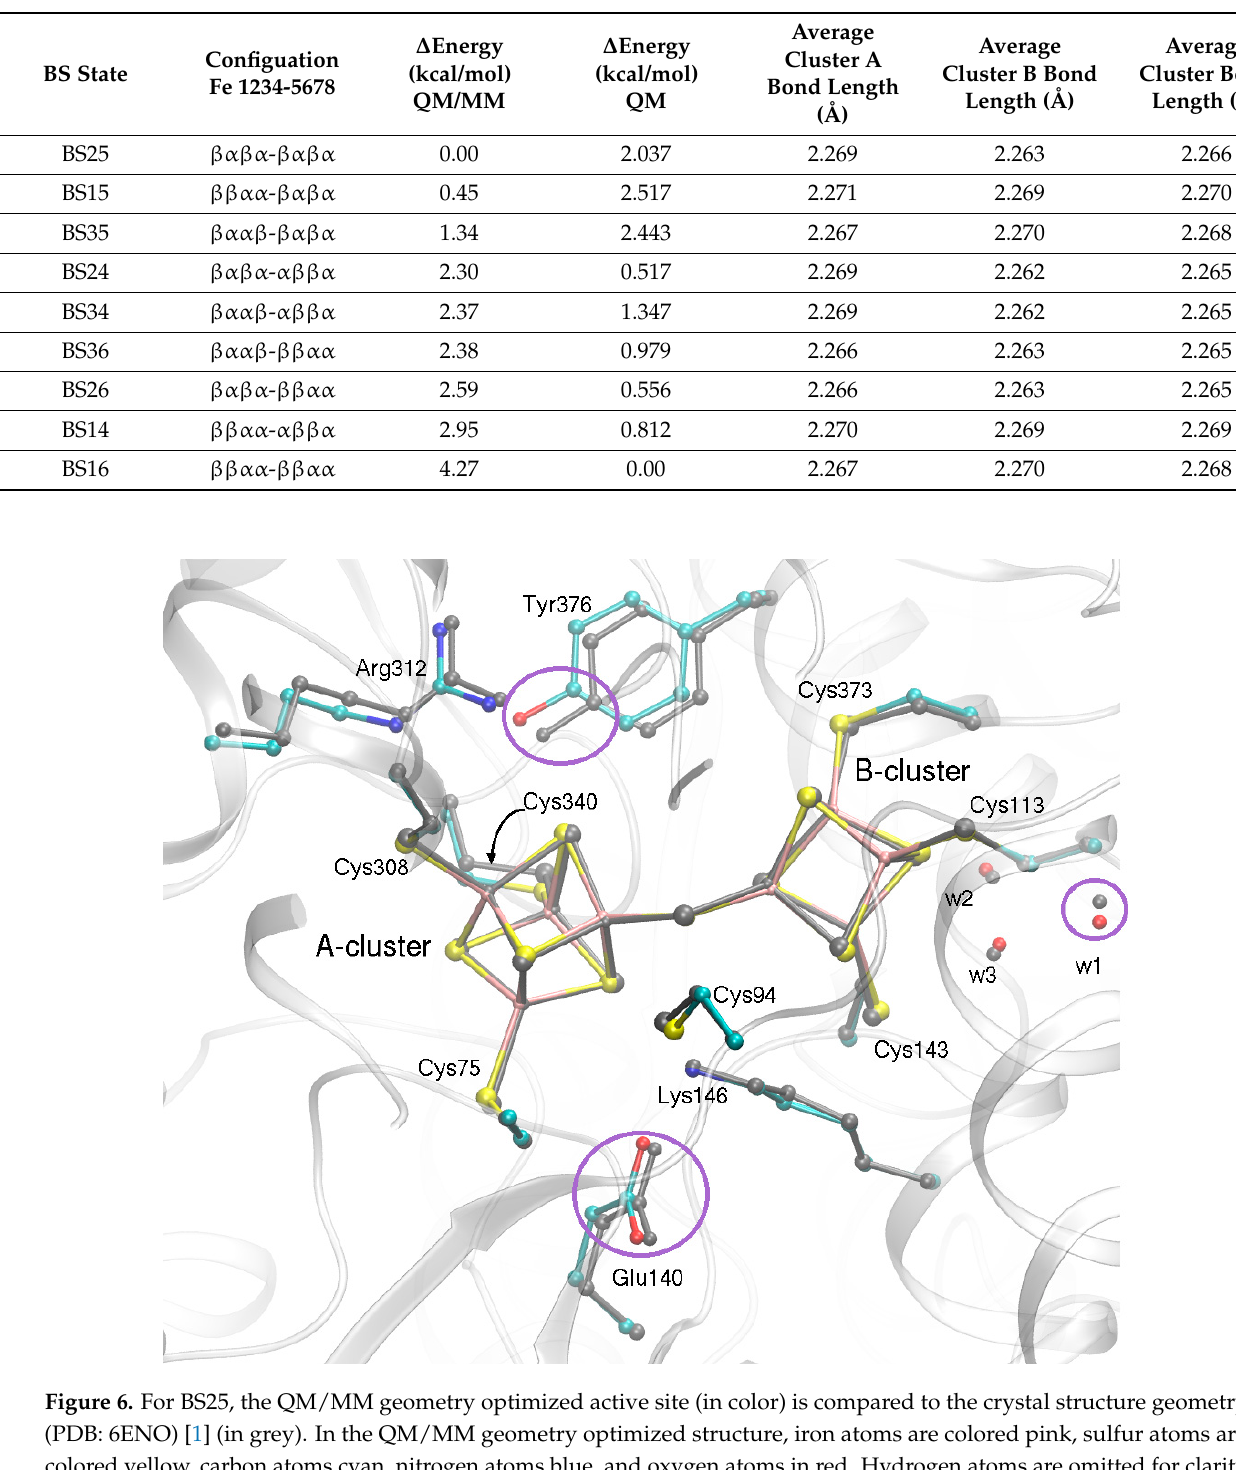
Table 2. Relative quantum mechanical/molecular mechanical (QM/MM) and QM energy differences (kcal/mol) and average QM/MM bond lengths (Å) for each cubane cluster are reported for each of the nine BS ( S = 0) configurations.